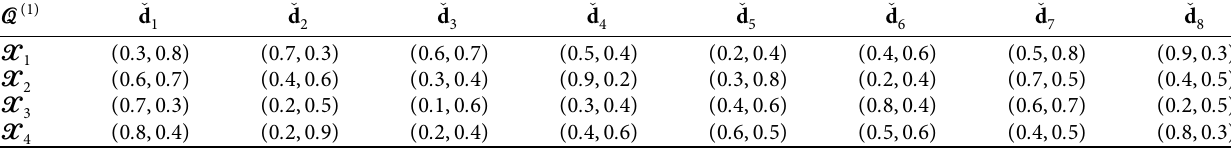
Table 1: Decision matrix for alternative Q ( 1 ) .